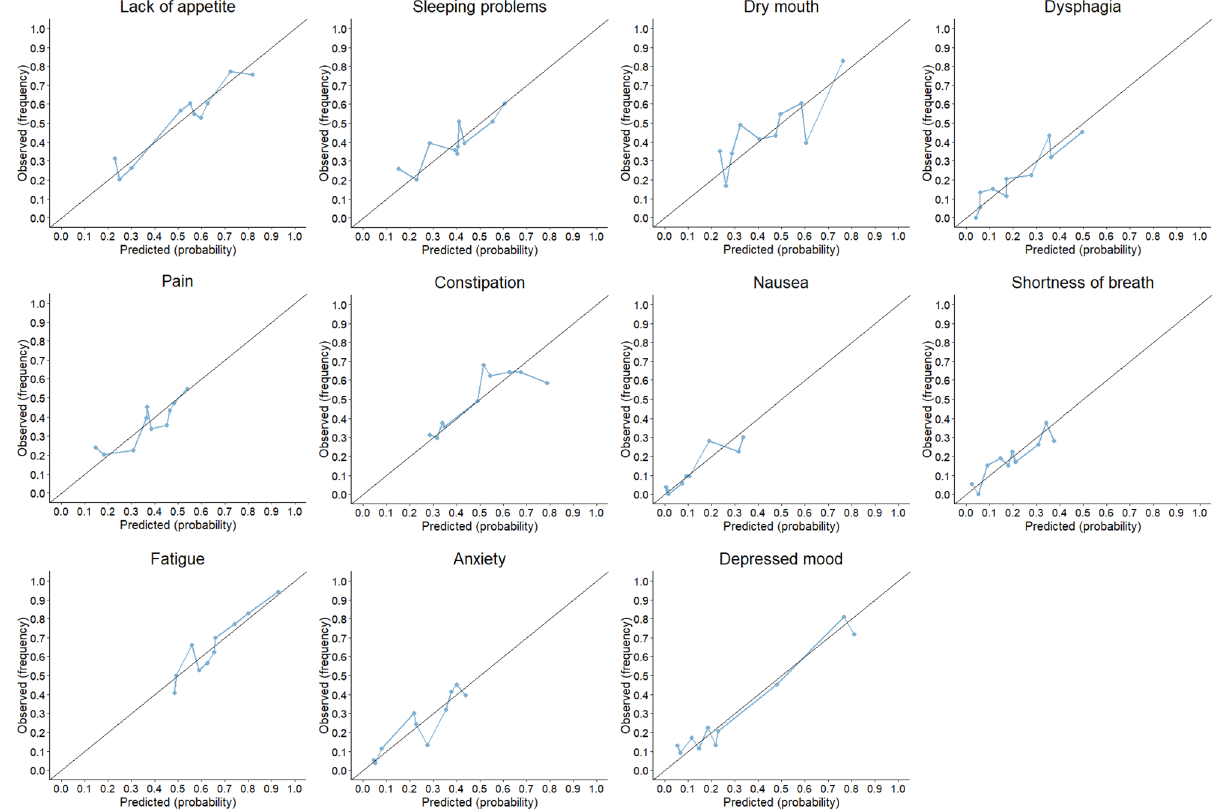
Figure 2. Calibration plots per predicted simultaneous symptom. The mean observed frequencies are plotted against the mean predicted probabilites per decile. Each decile represents a group of patients with a similar conditional probabilty predicted by the model. The black line corresponds to a model with ideal calibration, that is, a model that perfectly predicts the conditional